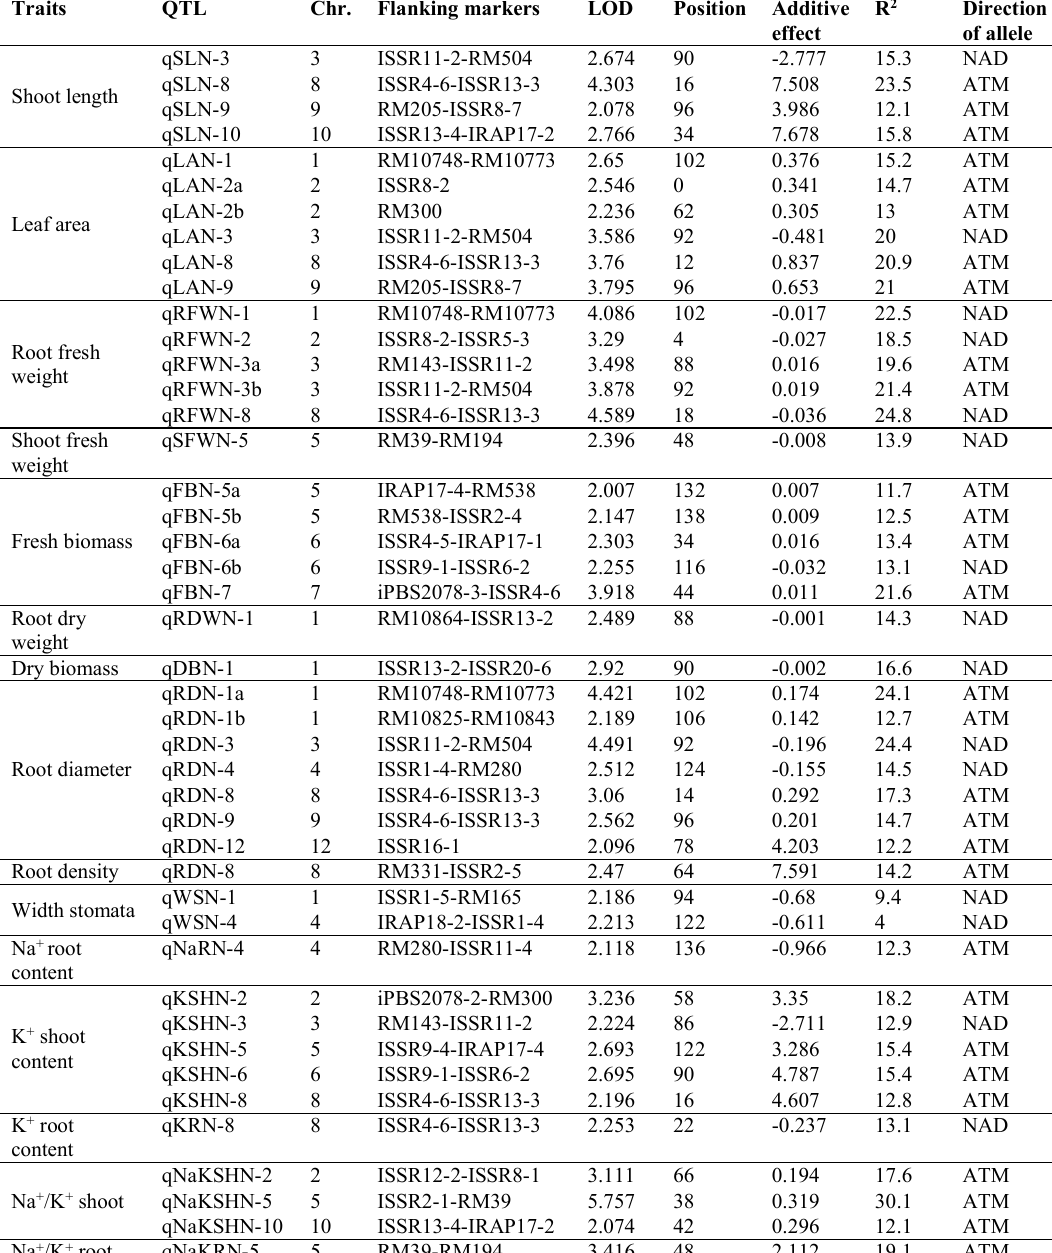
Position LOD Flanking markers Chr. QTL